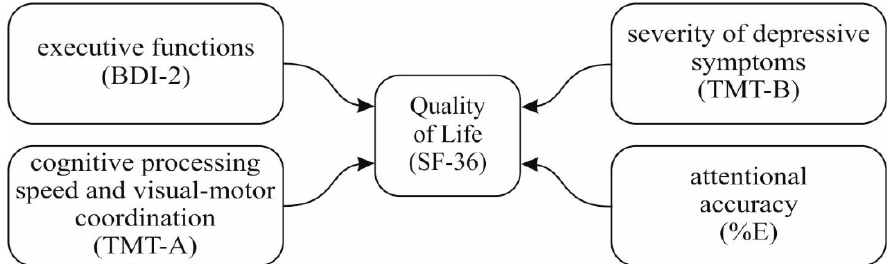
Figure 1. Predictors of the quality of life of women participating in the 12-week Nordic Walking training program supported by vitamin D supplementation.